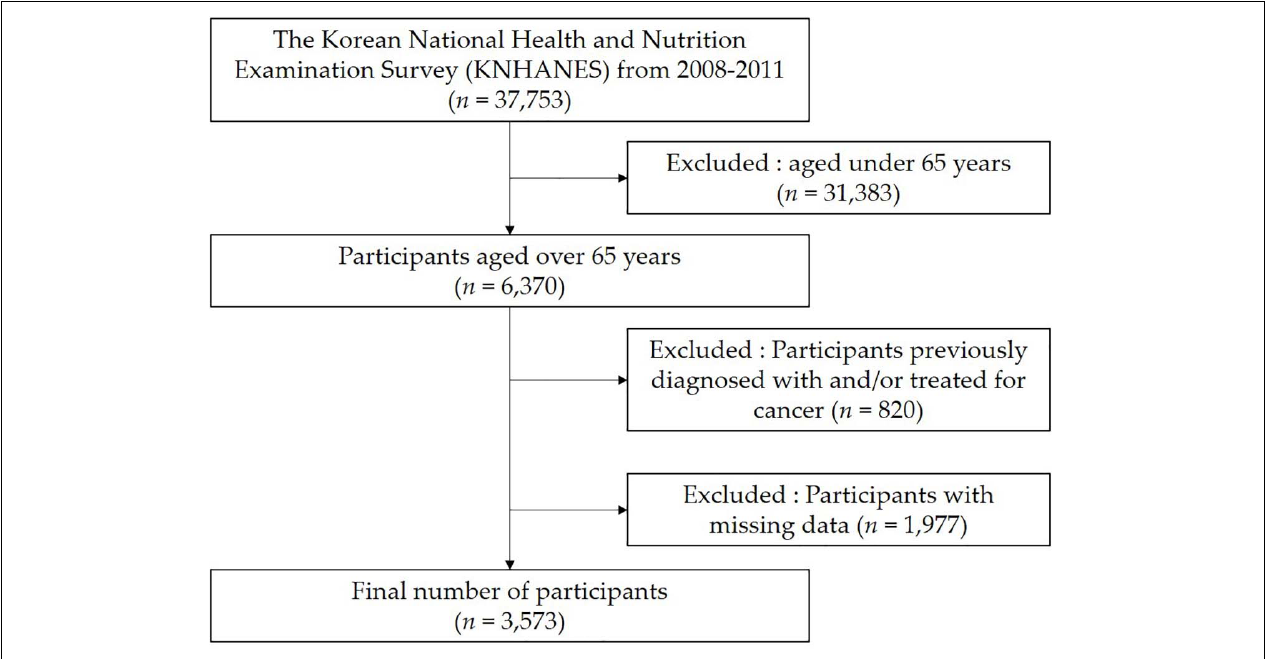
FIGURE 1 | Flow diagram for the selection of study